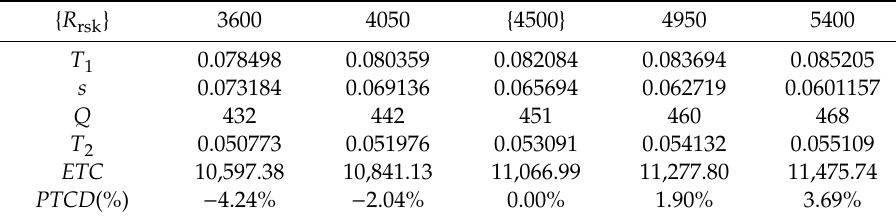
Table 10. Sensitivity analysis when the fixed risk cost